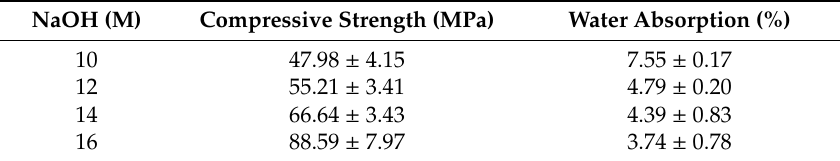
Table 5. Water absorption of fly ash-based geopolymer products.